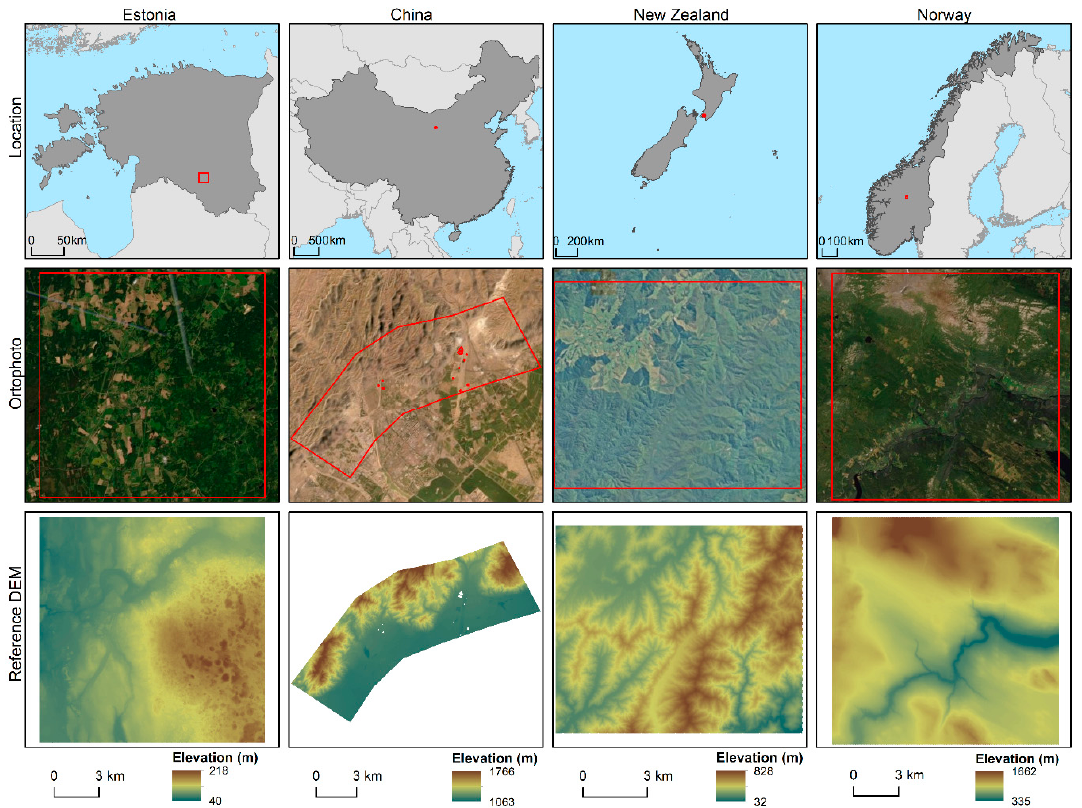
Figure 1. Locations of the four study areas, and images of their topography. The reference digital elevation models (DEMs) were obtained using local-scale Light Detection and Ranging (LiDAR) surveys (Estonia, Norway, New Zealand) and Pleiades 1A images (China).